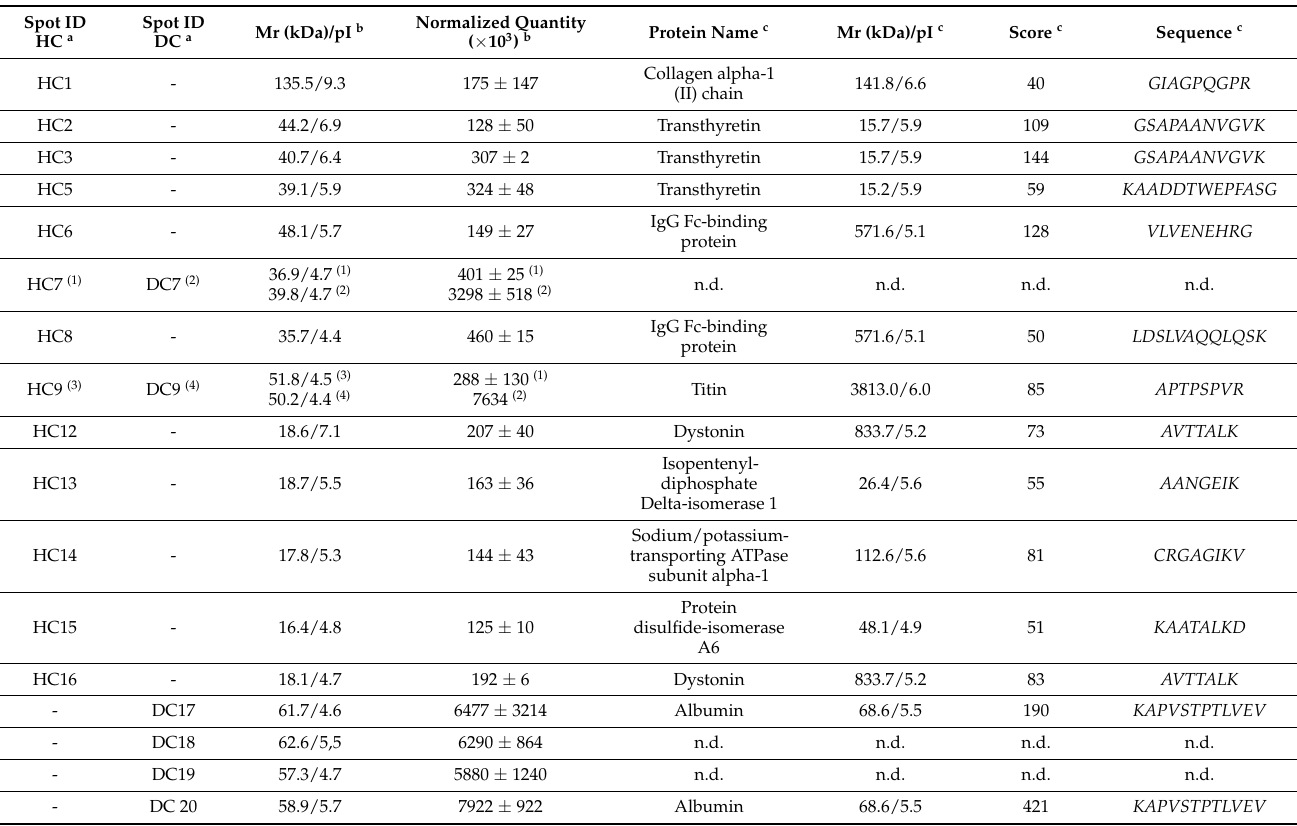
Table 1. Identification of proteins in healthy (HC) and diseased (DC)